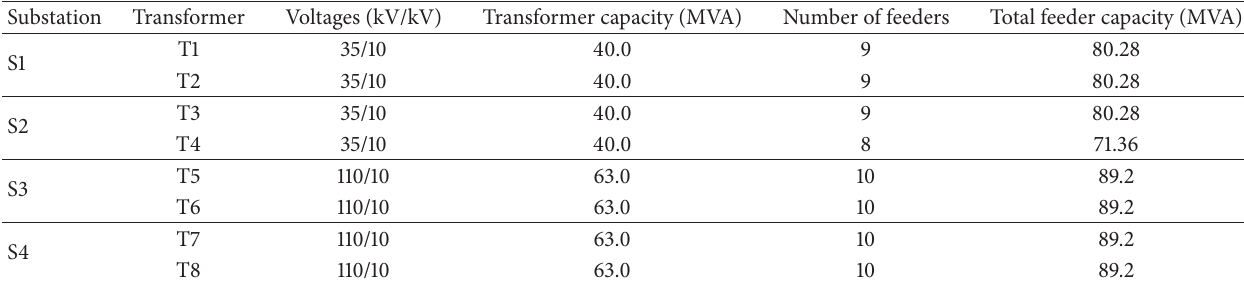
Table 1: Profile of test